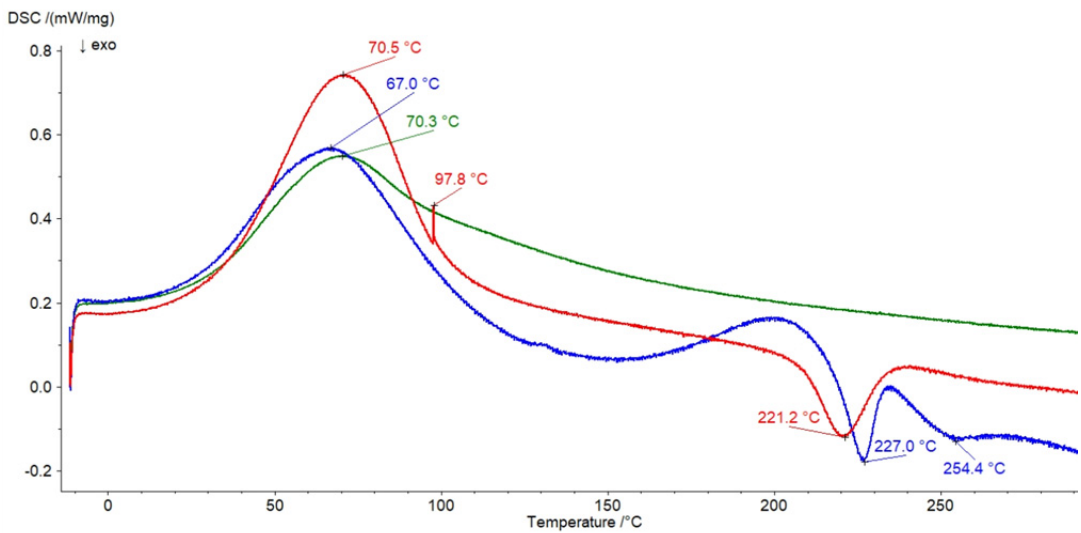
Figure 10. The thermograms of formulation F7 (red), formulation F10 (green), and the physical mixture of HA and PA (blue).